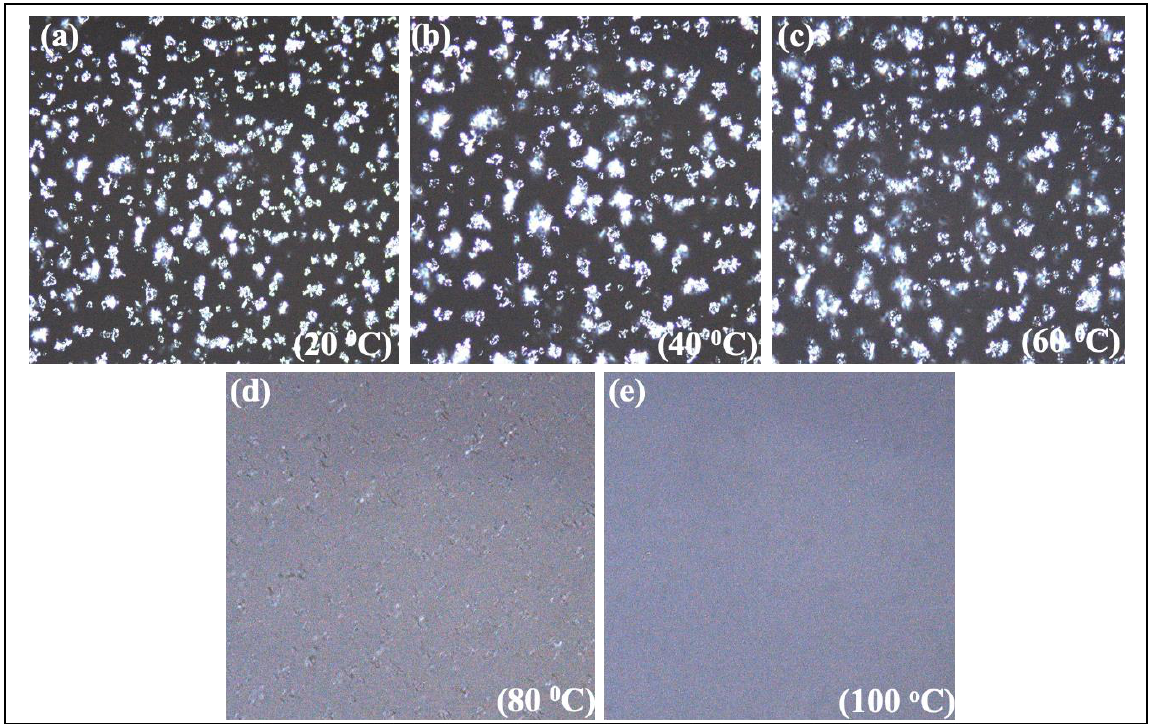
Figure 4. Polarized light microscopy of 3.4% carnauba wax (CNW) oleogel. a = wax crystal at 20 °C; b = wax crystal at 40 °C; c = wax crystal at 60 °C; d = wax crystal at 80 °C; e = wax crystal at 100 ( b ) = wax crystal at 40 ◦ C; ( c ) = wax crystal at 60 ◦ C; ( d ) = wax crystal at 80 ◦ C; ( e ) = wax crystal at °C 100 ◦